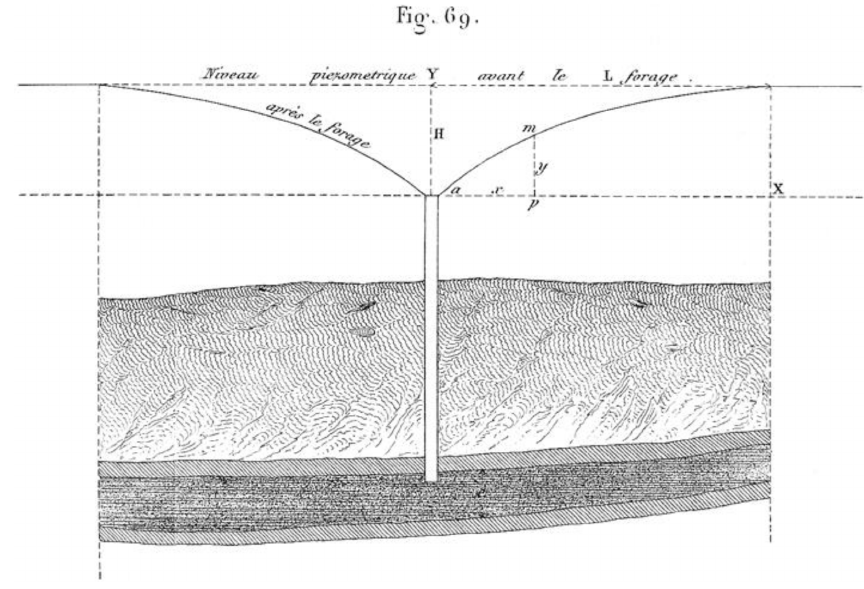
Figure 5. Plot from Dupuit (1863) showing the radial flow toward a flowing well penetrating a confined aquifer, which caused head loss with a cone of depression in the potentiometric level (“niveau piezometrique”). It is clear that the potentiometric level of the cone of depression is still above the land